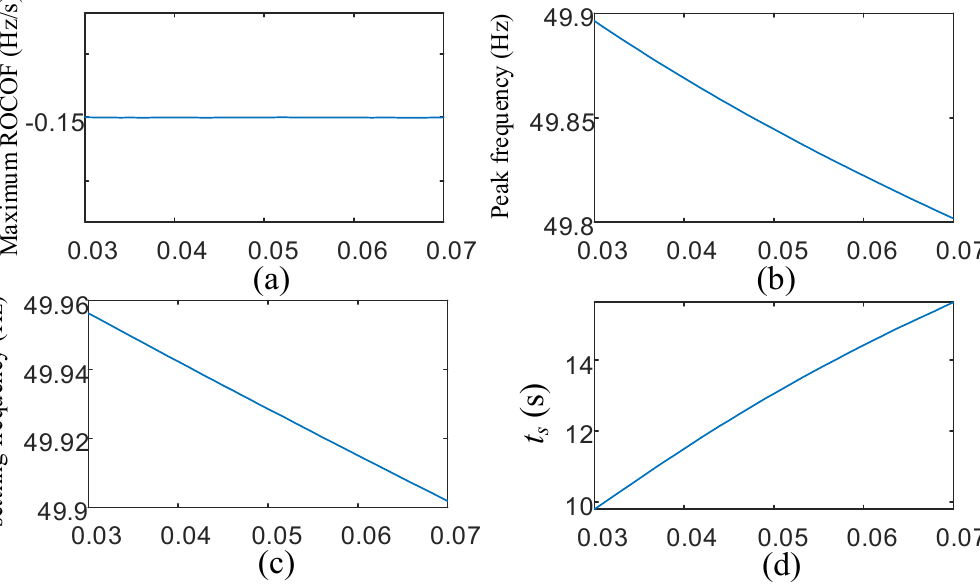
Figure 5. Speed droop influence on performance indices: ( a ) maximum ROCOF, ( b ) peak frequency, ( c ) settling frequency, and ( d ) settling time.